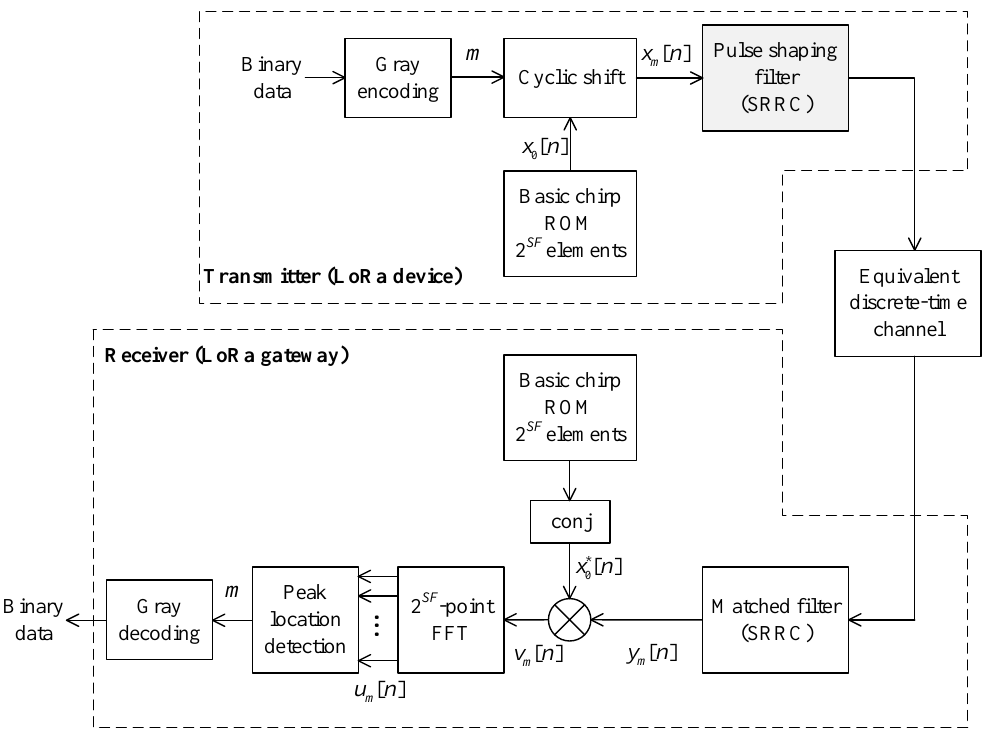
Figure 1. Block diagram of a LoRa (Low-Power Long-Range) system implementing pulse shaping and matched